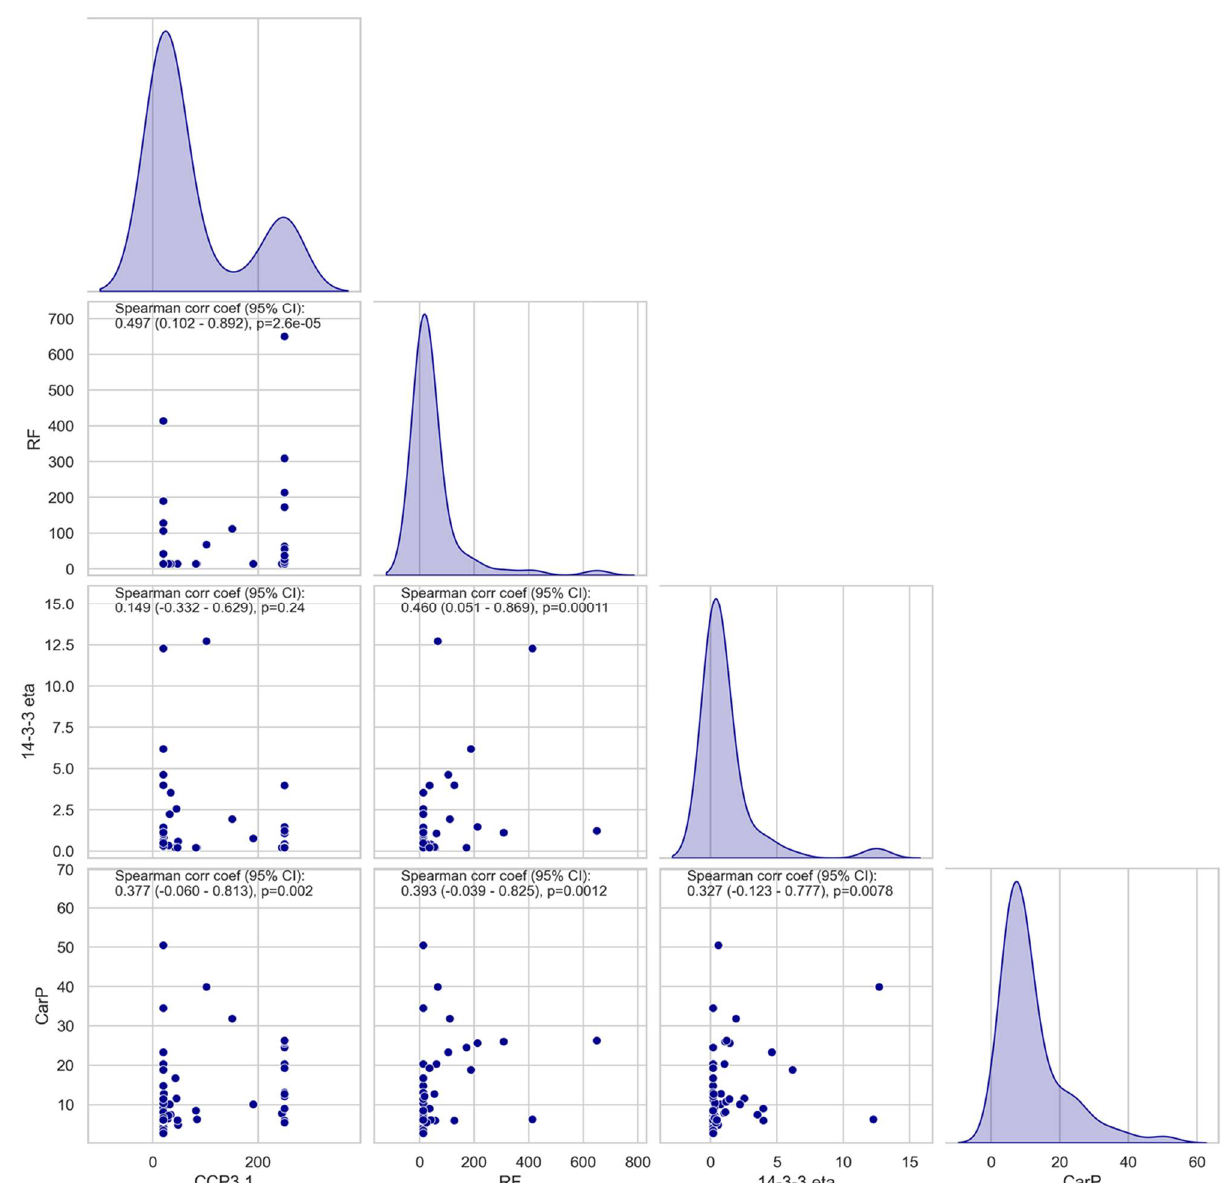
Figure 3. Correlation diagram between rheumatoid arthritis (RA)-associated markers anti-CarP, anti-CCP3.1, RF, and 14-3-3 eta. Spearman’s coefficients and p -values are indicated in the figure.